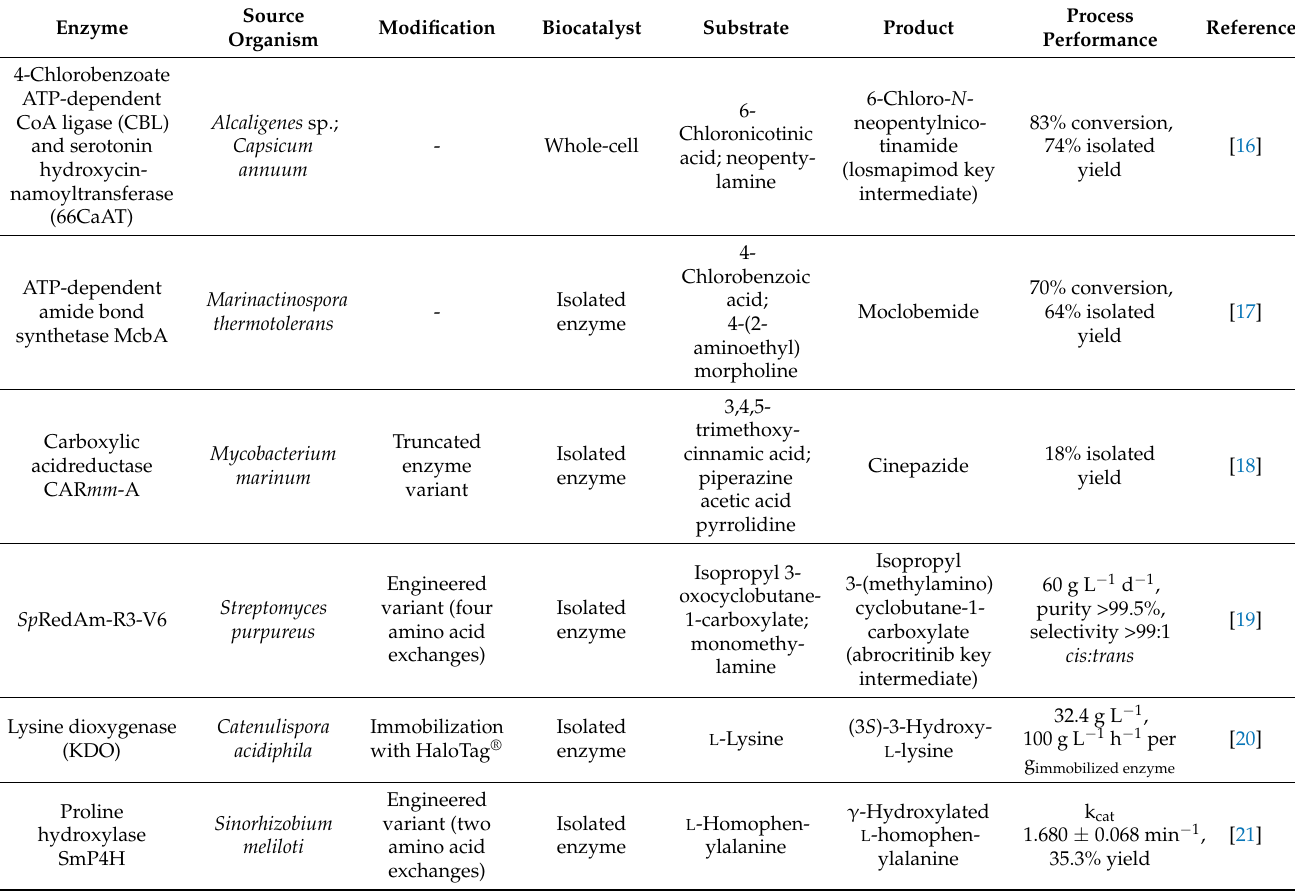
Figure 1. General phases of secondary (2 ◦ ) metabolism. Table 1. Overview of mentioned enzymes from the natural